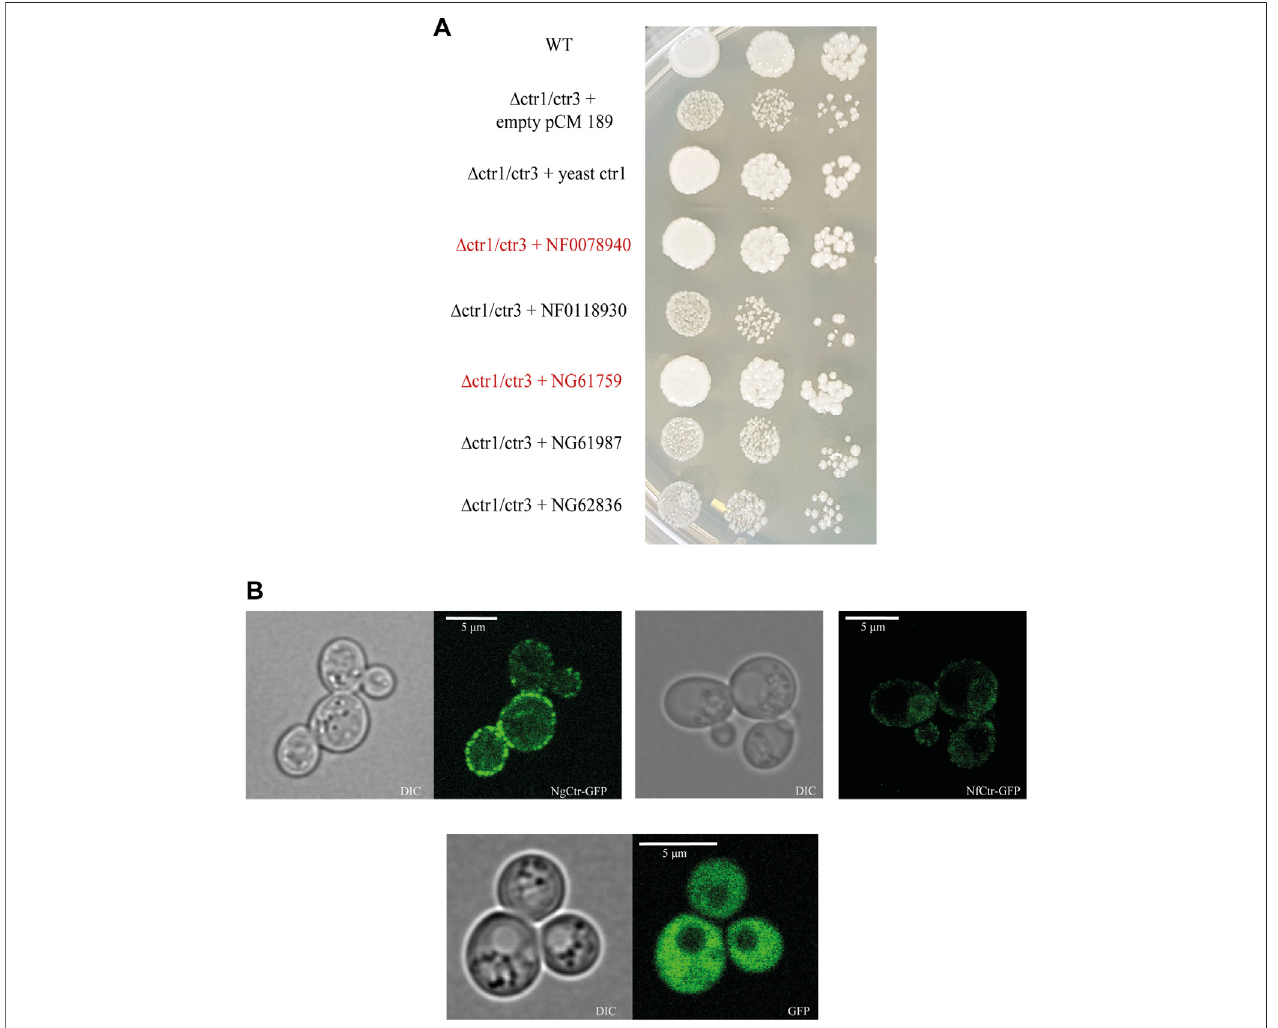
FIGURE 1 | Identi fi cation of copper uptake proteins (Ctrs) of Naegleria gruberi and Naegleria fowleri. (A) Functional complementation spot assay of NgCTRs and NfCTRs in Δ ctr1/ctr3 mutant yeast cells lacking genes for high-af fi nity copper transporters. Wild-type BY4741 cells transformed with the empty tetracycline-regulated expression vector pCM189 and Δ ctr1/ctr3 mutant cells transformed with the same plasmid carrying yeast CTR1, NfCTRs (NF0078940, NF0118930) or NgCTRs (NG61759,NG61987,NG62836)werespottedontosyntheticcompletemediumwithouturacilwith2%raf fi noseasthecarbonsourceandgrownfor72 hat30 ° C. MutantyeastcellswithplasmidscontainingCTRgenesfrom N.fowleri (NF0078940)and N.gruberi (NG61759),whichfunctionallycomplementthemissingyeastcopper transporters CTR1 and CTR3, are marked in red. (B) Localization of NfCtr (NF0078940) and NgCtr (NG61759) by fl uorescence microscopy. Wild-type yeast BY4147 expressing copper transporters linked with GFP from N. gruberi NgCTR1-GFP (NG61759 + pUG35), N. fowleri NfCTR1-GFP (NF0078940 + pUG35), and GFP (empty pUG35 vector).